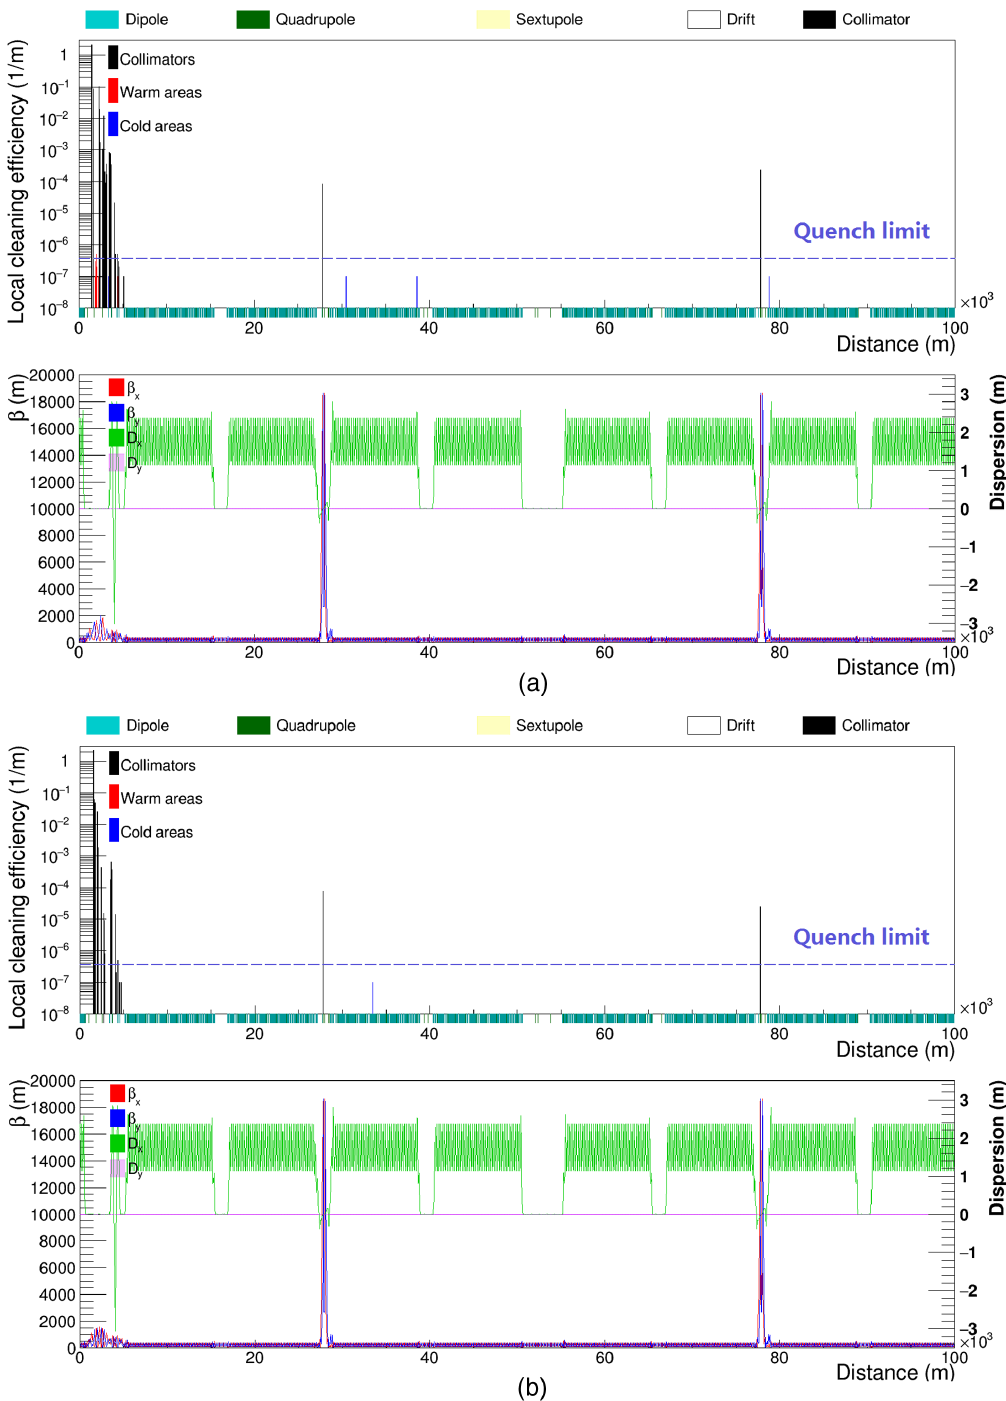
FIG. 11. Proton loss distribution along the full ring in lattice scheme I (a) and II (b), with initial vertical halo